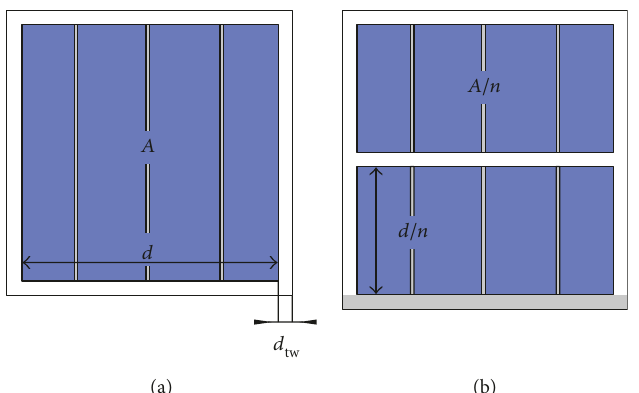
Figure 3: Increasing module area due to cell separation (grey stripe on (b)). The blue area represents the cell area, the space around the cell represents the tab width d tw , and the sum of both areas represents the module area. (a) Whole cell; (b) two half cells (i.e., n = 2 ).